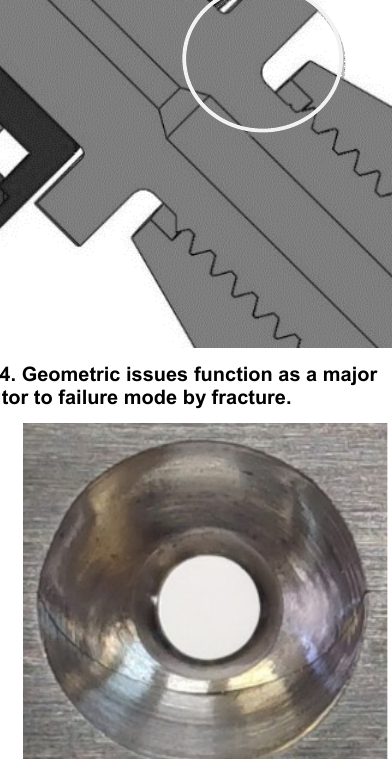
Figure 15. ICZ from BFP compliant with the required working state.